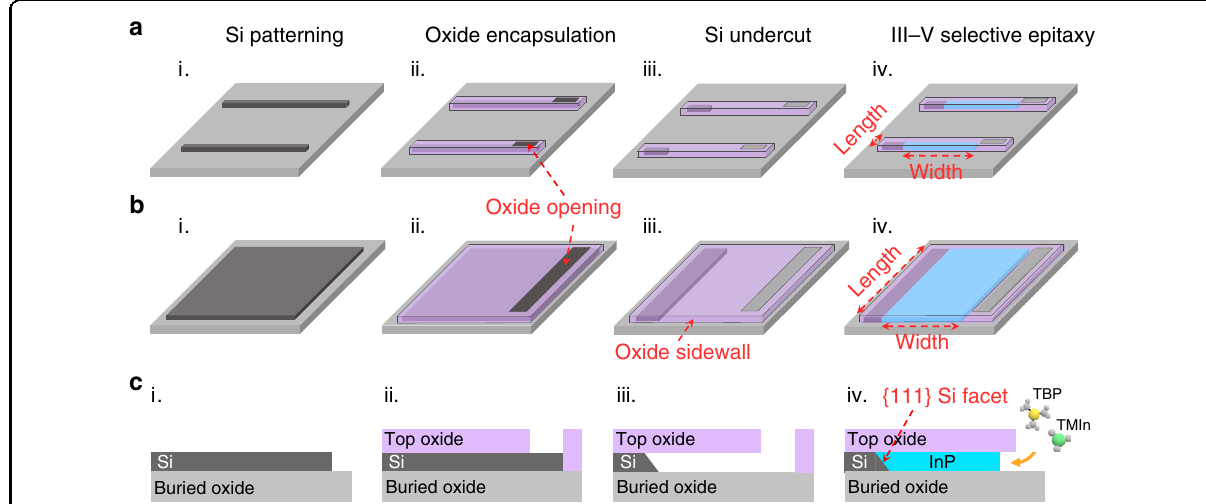
Fig. 1 The concept of growing in-plane InP sub-micron wire and membrane array on (001) SOI wafers. a , b Schematic of selective lateral hetero-epitaxy of InP sub-micron wires and membranes. c Cross-sectional schematics of each step. (i) Si device layer patterning. (ii) Oxide encapsulation (oxide deposition and opening). (iii) Anisotropic Si wet etching to form Si undercut. (iv) Selective epitaxy of in-plane InP sub-micron wires and membranes. De fi nition of InP sub-micron wires and membranes dimensions: the width refers to the dimension along lateral epitaxial direction, while the length denotes the orthogonal dimension of the oxide patterns de fi ned by lithography, as indicated in step